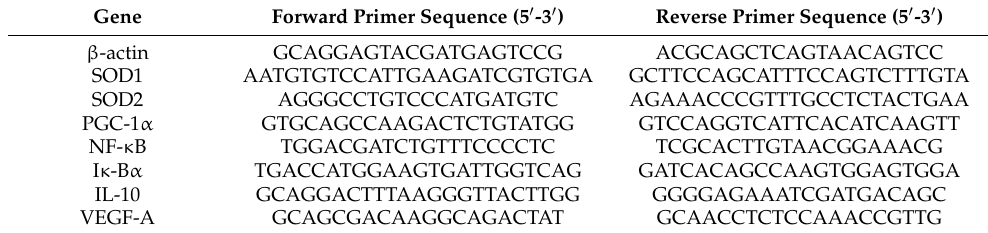
Table 1. PCR primers used in this